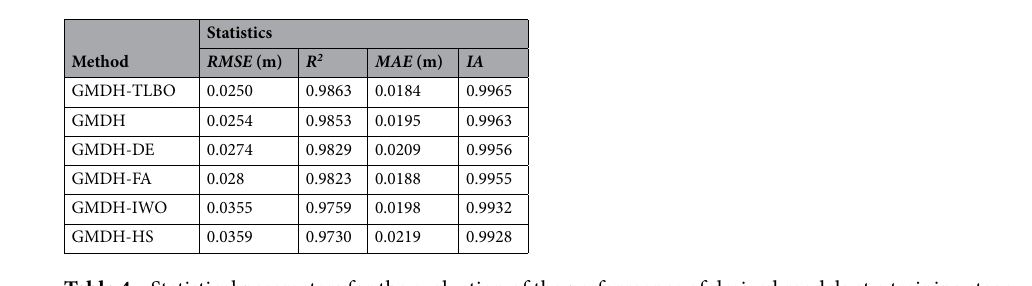
Table 4. Statistical parameters for the evaluation of the performance of derived models at a training